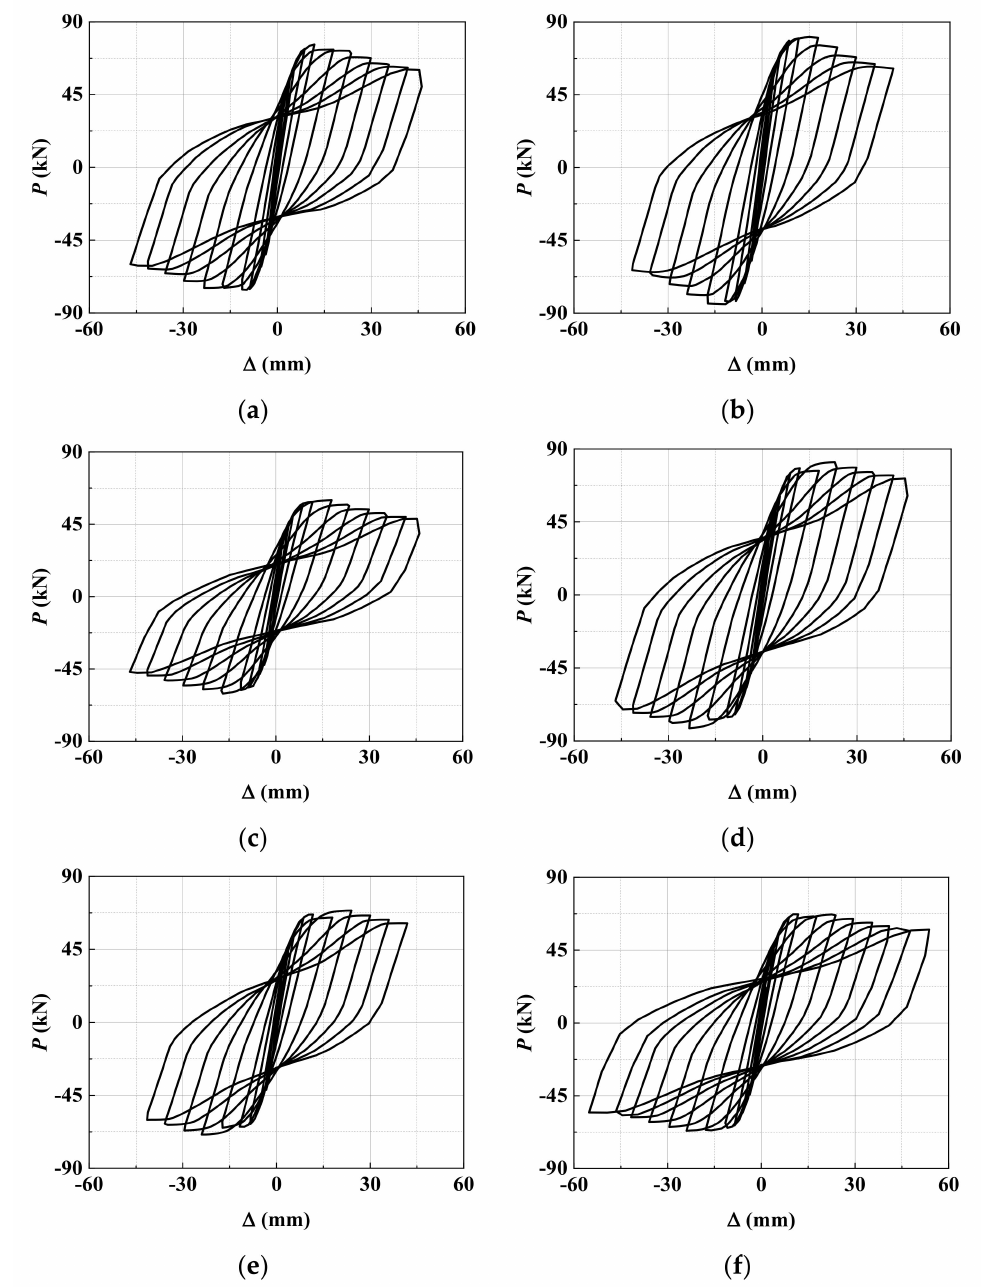
Figure 30. Parameter analysis by numerical simulation. ( a ) JP-A0.225. ( b ) JP-A0.3. ( c ) JP-L12. ( d ) JP-L16. ( e ) JP-J100. ( f )